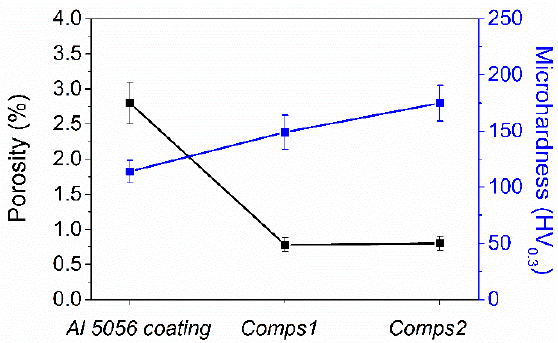
Figure 3. Porosity and microhardness results of the cold-sprayed Al 5056 coating and SiC p / Al 5056 composite coatings on the magnesium substrate.